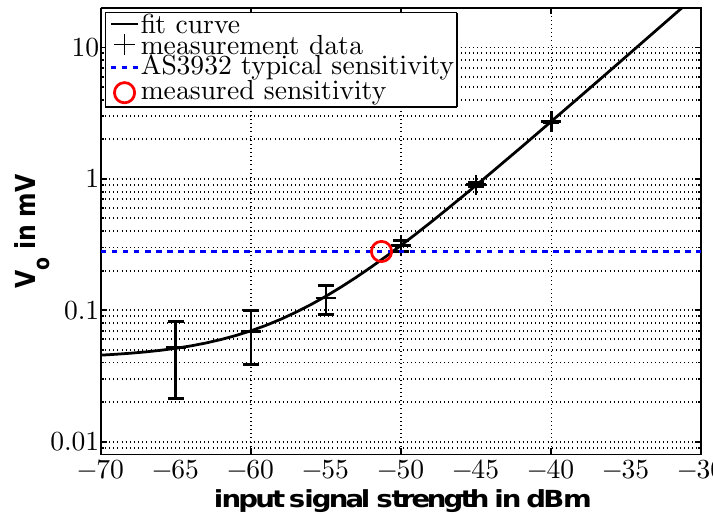
Figure 9. Measured voltage at the rectifier output with one active antenna. The typical sensitivity of the AS3932 is depicted as the dotted line and the red circle shows the measured sensitivity.